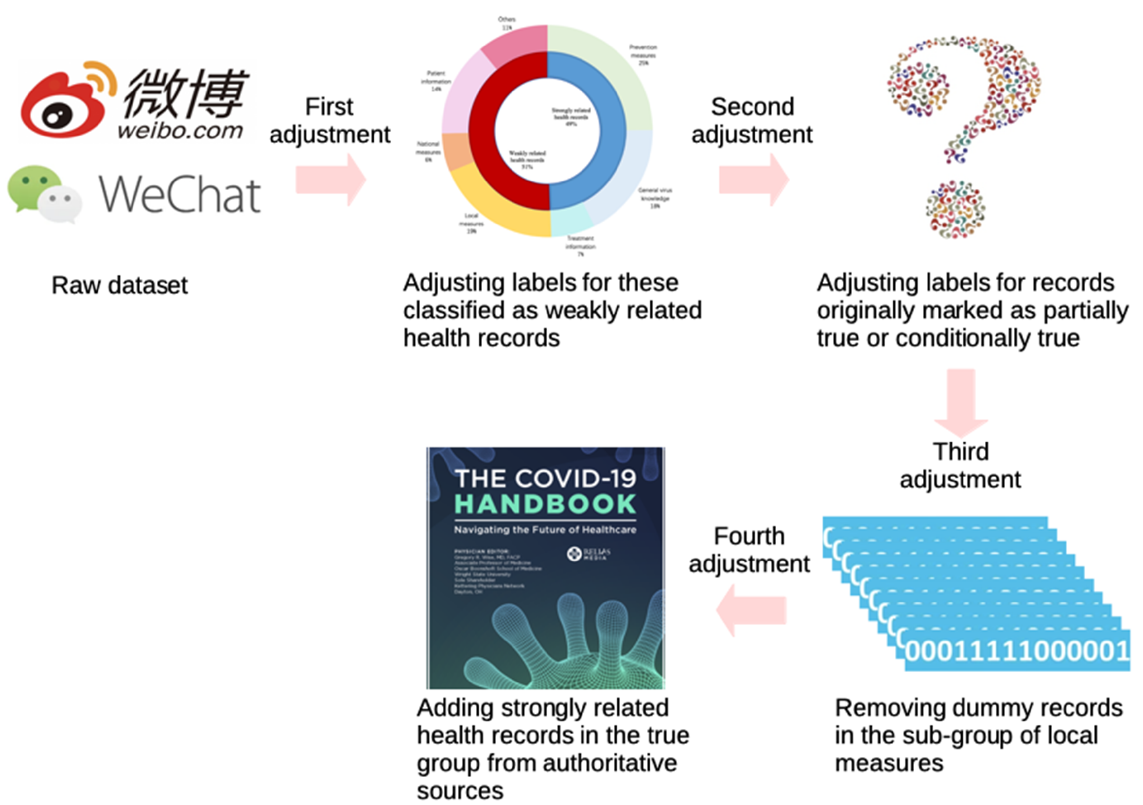
Figure 1. Process of four times label adjustment.